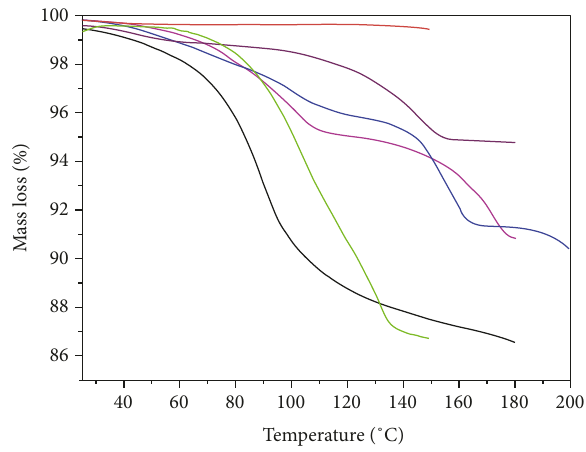
Figure 2: Thermo gravimetrical curves of OMP (red) and fi ve OMP salts (OMP-K (violet), OMP-Na (blue), OMP-Mg (pink), OMP-Li (green), and OMP-Ca (black)).